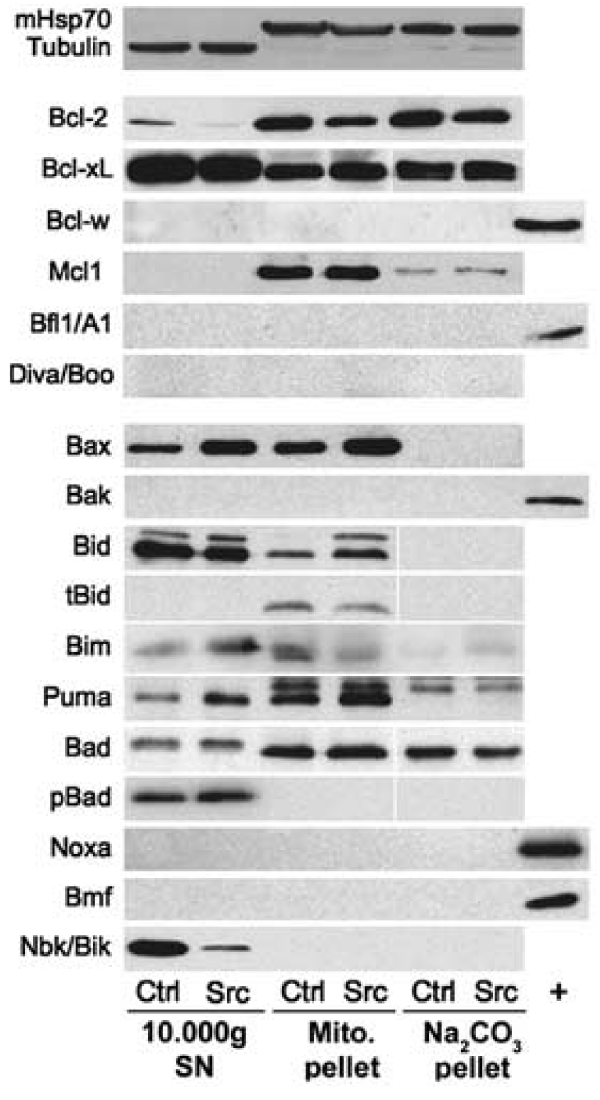
Figure 3. Western blotting analyses of the Bcl-2 family proteins in control (Ctrl) and v-src-transformed cells (Src). Differential centrifugation was used for cell fractionation. Each experiment was repeated at least twice. Mitochondrial Hsp70 and a-tubulin were used as loading controls for mitochondrial fractions and 10 000 6 g supernatants (10 000 g SN), respectively (loading 100 mg proteins). Whole cell lysates from HeLa (Bcl-w), BP3 (Bfl1/A1), 293T (Noxa and Bmf) and WT MEF (Bak) cells were used as positive controls when proteins were undetected. Data were reprinted with permission from [5].